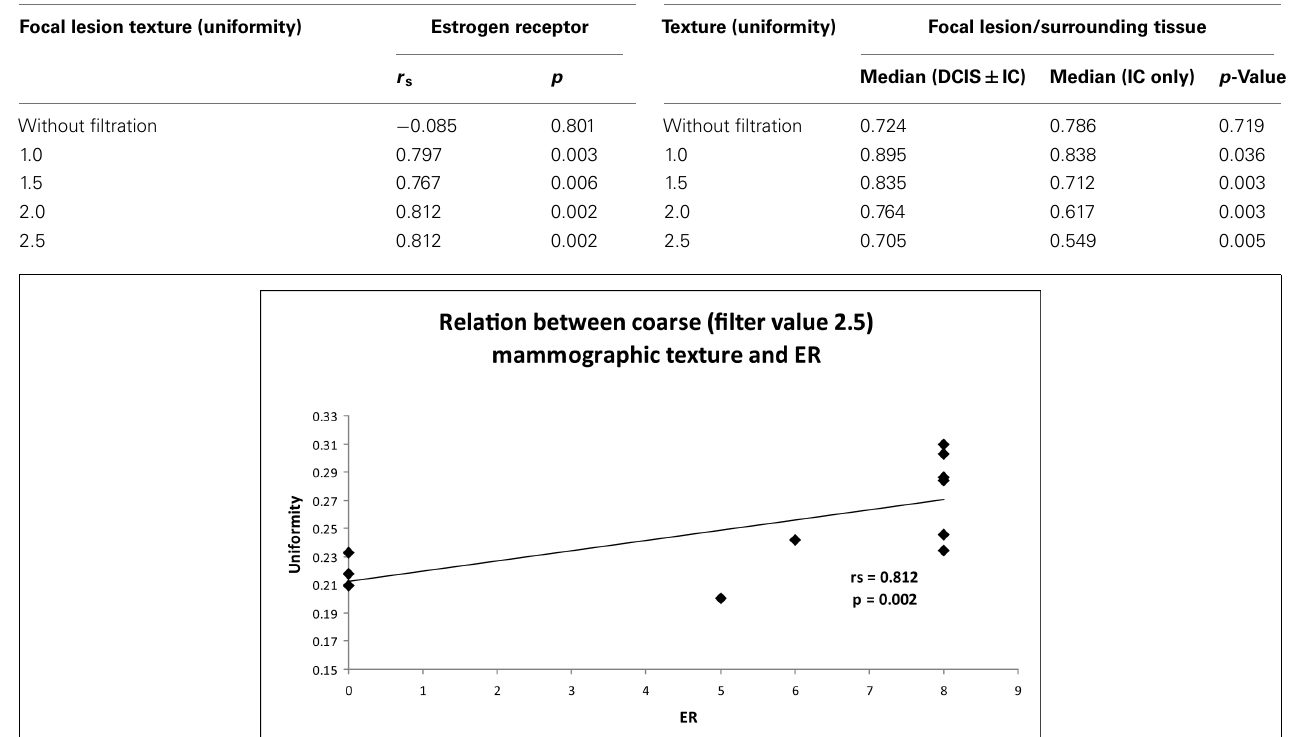
Table 4 | Median values for focal lesion/surrounding tissue texture (uniformity) between DCIS ± IC and IC only along with the p -values obtained from the MannWhitney test.